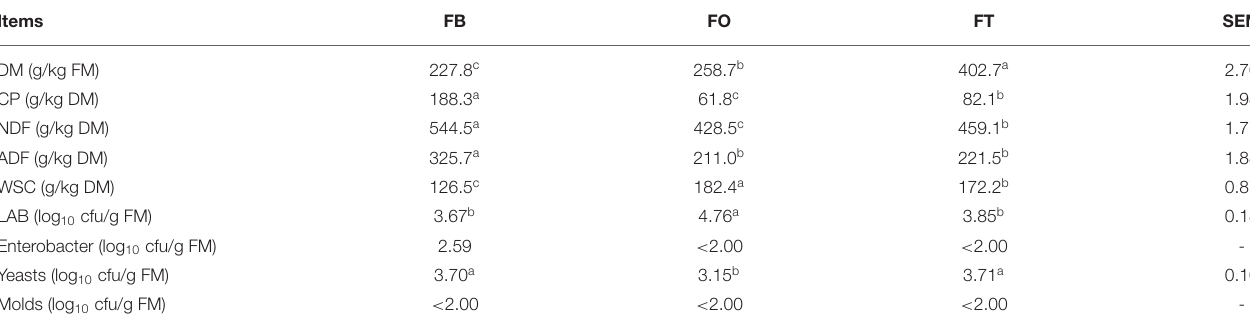
TABLE 1 | Chemical composition and microbial population in fresh raw materials. Items